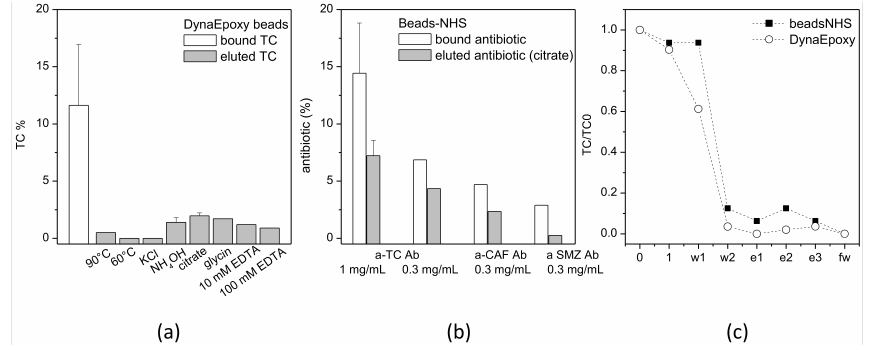
Figure 10. Binding and release of antibiotics from beads functionalized with antibodies. ( a ) Binding to DynaEpoxy beads functionalized with a-TC-Ab through protein G and elution of TC with different conditions. The percentage of TC is referred to the initial amount of antibiotic added to beads, set as 100%. ( b ) Binding of different antibiotics to PureCubeNHS beads functionalized with the respective antibodies and elution with citrate. ( c ) On-chip purification of TC captured by a-TC Ab bound to PureCubeNHS (solid squares) or DynaEpoxy (open